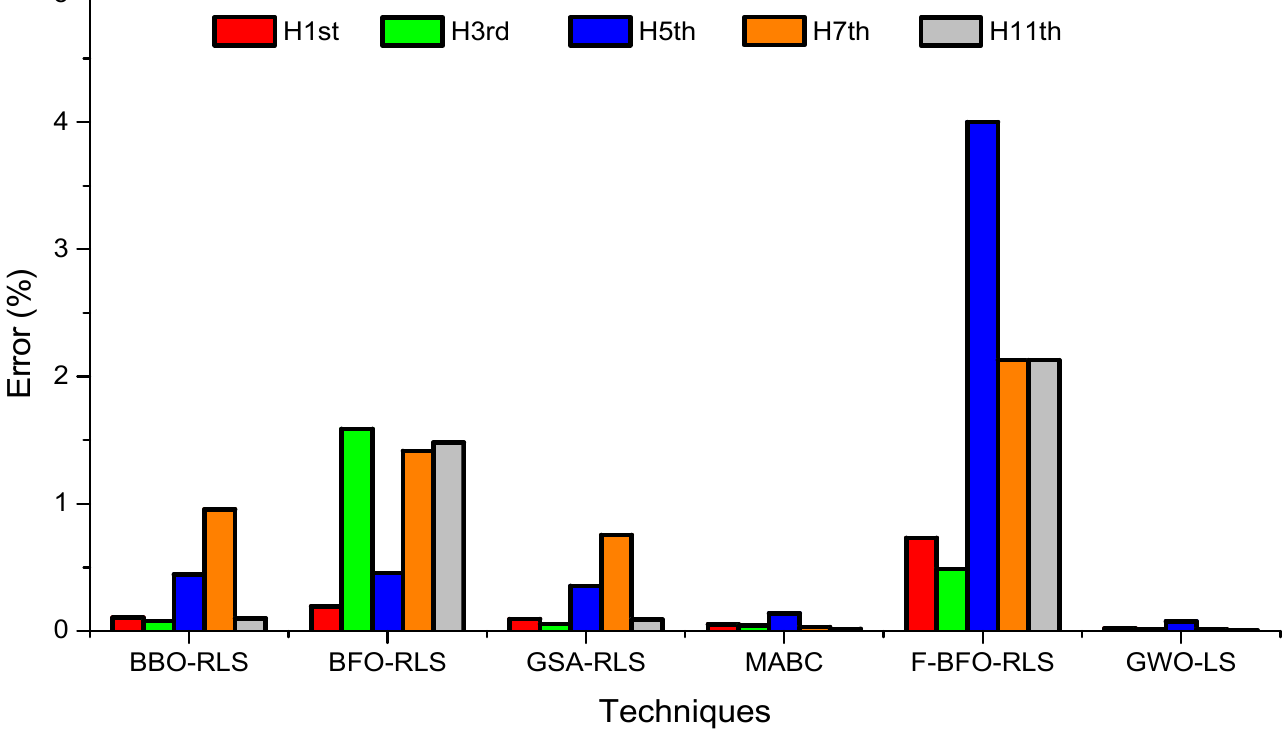
Figure 9. Comparison of amplitudes error for case study I.